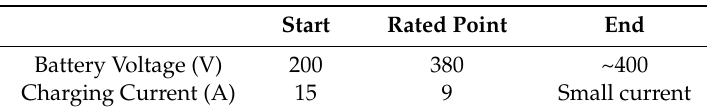
Table 2. Battery charging profile.